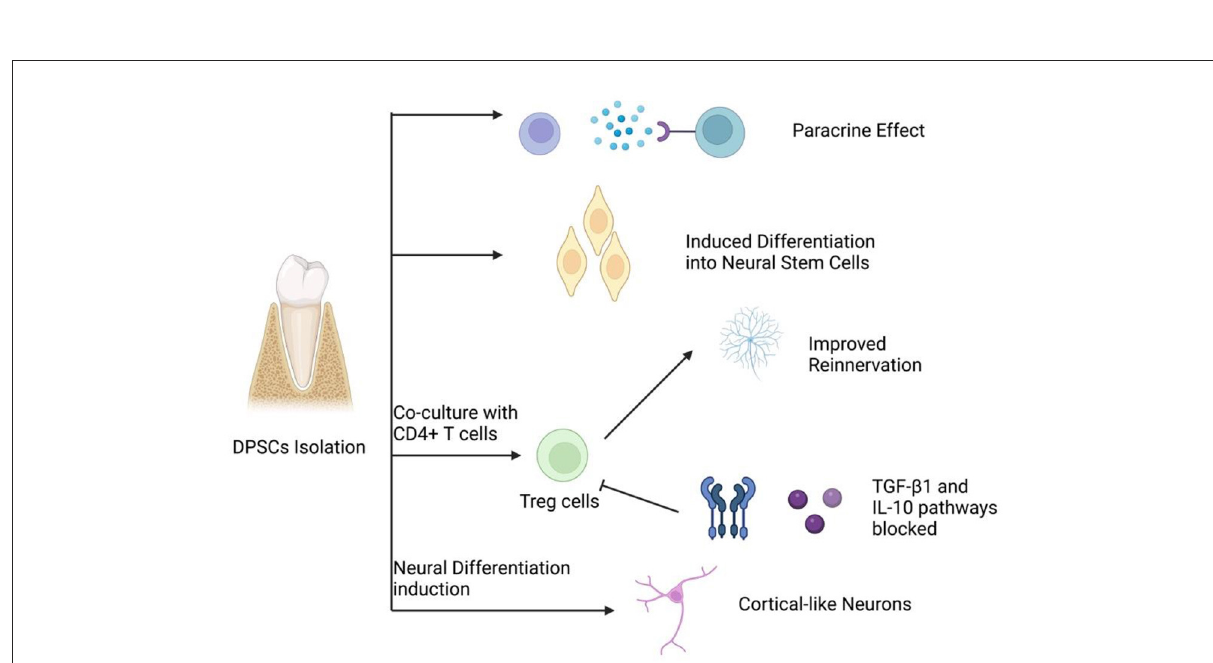
FIGURE2 Four main mechanisms of peripheral nerve regeneration by